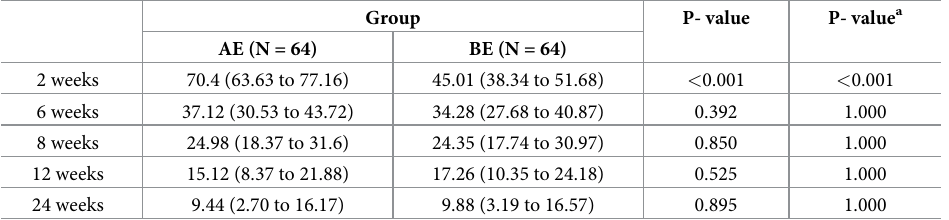
Table 2. Results of patient-reported outcome (DASH), show as mean (95%CI). Group P- value P- value a